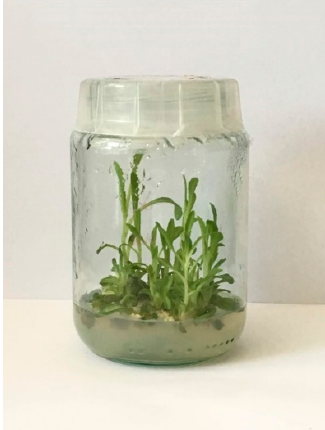
Figure 8. The microshoot in vitro cultures of I. tinctoria L. (agar Murashige and Skoog medium with 1 mg/L BA and 1 mg/L NAA) after two weeks of growth.